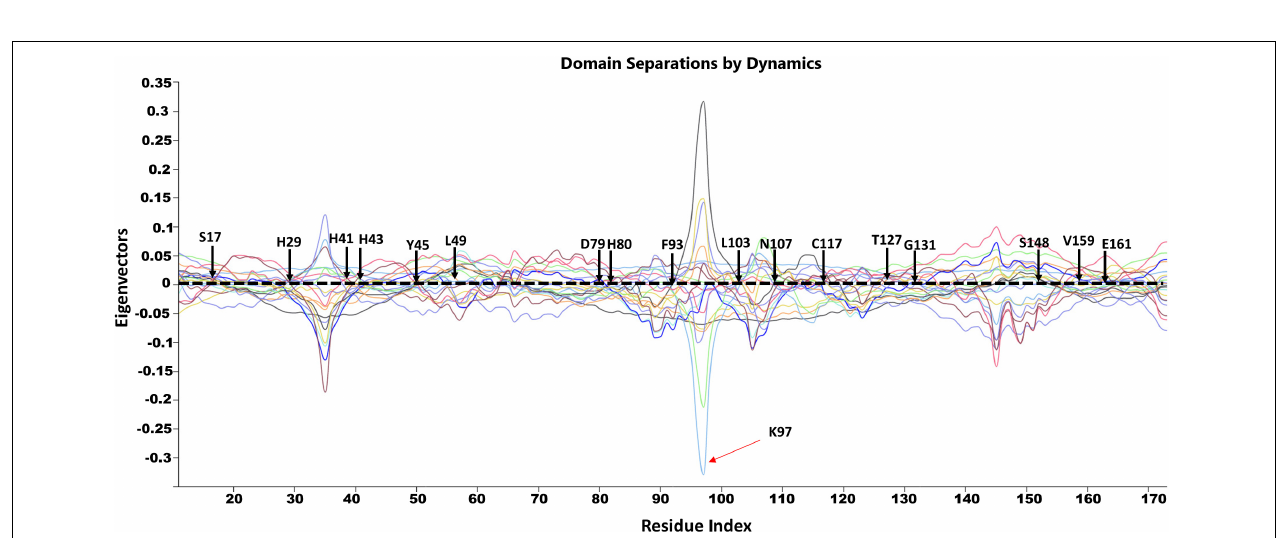
FIGURE 10 | (A) The structure of P. falciparum PTPS and the metal center (active site) showing in the circled zoom with the active site residues: H29, H41, H43, and the two catalytically important residues T127 and E161. (B) Boxed zoom showing the location of the identified high vibrating residues.